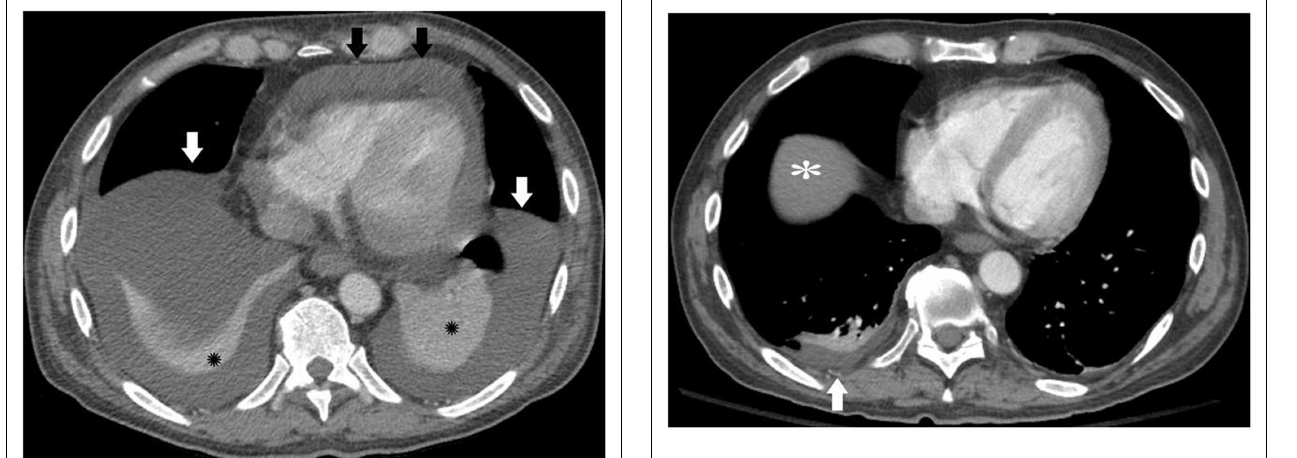
FIGURE 2 | Post-treatment CT image after two cycles of fludarabine and cytarabine and four cycles of decitabine alone .White arrow = residual small right pleural effusion. No left pleural effusion or pericardial effusion.White asterisk =